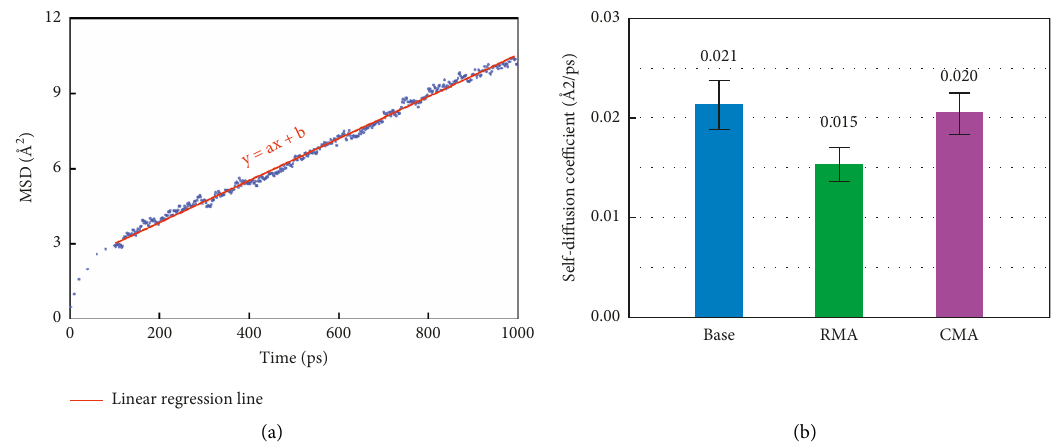
Figure 9: Effect of modifiers on the diffusivity of asphalt: (a) linear fitting of the MSD data; (b) self-diffusion coefficients of base and modified